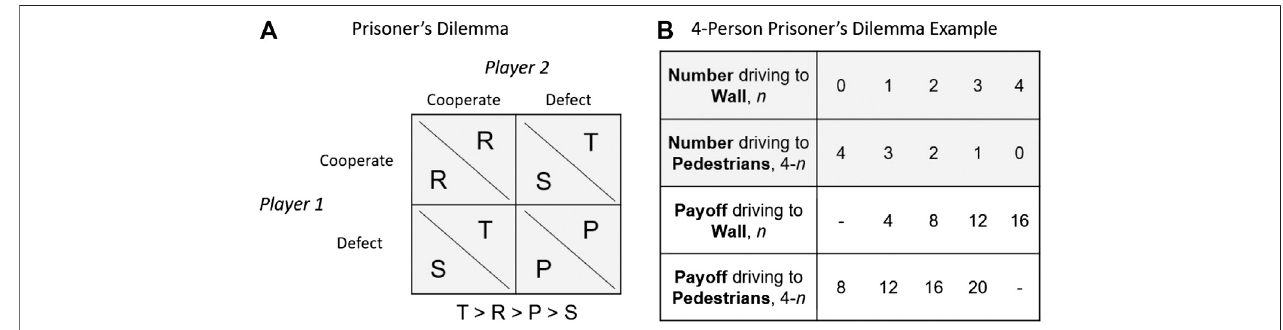
FIGURE1| Game-theoreticformulationformoraldilemmasinvolvingAVs: (A) theprisoner ’ sdilemma; (B) anexampleofaformulationoftheAVmoraldilemmaasa 4-person prisoner ’ s dilemma.